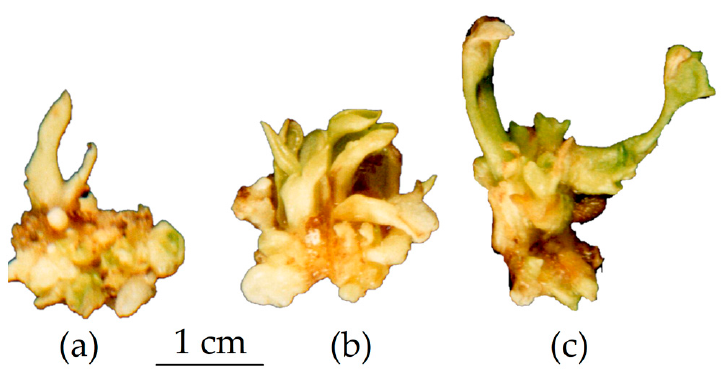
Figure 5. Different types of Syngonium podophyllum calli: ( a ) Control callus obtained in MS62 medium without cysteine. ( b ) Control callus obtained in N62 culture medium without cysteine. ( c ) Callus obtained in N69 culture medium supplemented with cysteine. It can be seen that the callus was much greener when it was cultivated in N69 culture medium, and that the shoots were more elongated in the presence of cysteine.